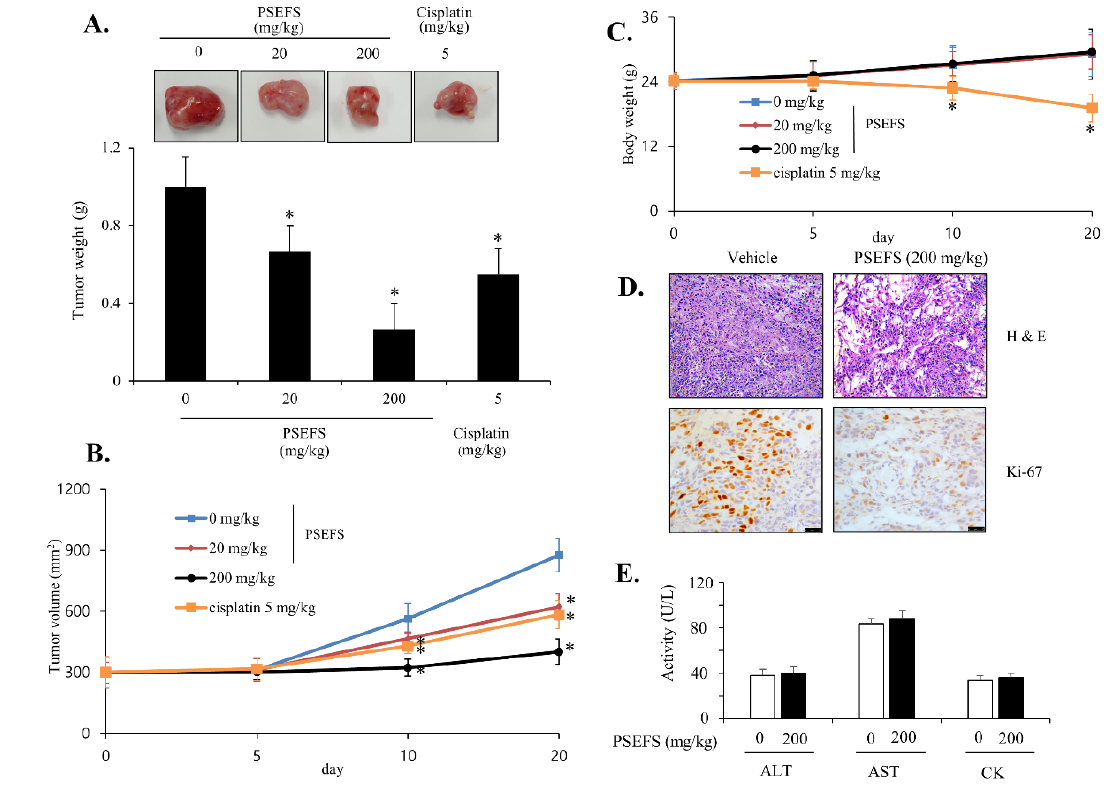
Figure 5. Antitumor e ffi cacy of PSEFS in xenografted mice transplanted with T24 cells. The indicated concentrations of PSEFS (0. 20, and 200 mg / kg) and cisplatin (5 mg / kg; positive control) were orally administered to compare antitumor e ffi cacy. ( A ) Appearance and quantification of weights of tumors separated from xenografted mice following treatment with PSEFS or cisplatin. ( B ) Tumor volumes were evaluated daily in xenografted mice. ( C ) Body weight loss was assessed during PSEFS administration and cisplatin treatment. ( D ) H&E and Ki-67 staining were performed to evaluate tumor growth. ( E ) After treatment with PSEFS, hematobiochemical markers (AST, ALT, and CK) were assessed in plasma from xenografted mice. Data represent the mean ± SD (n = 5). * p < 0.05 vs.